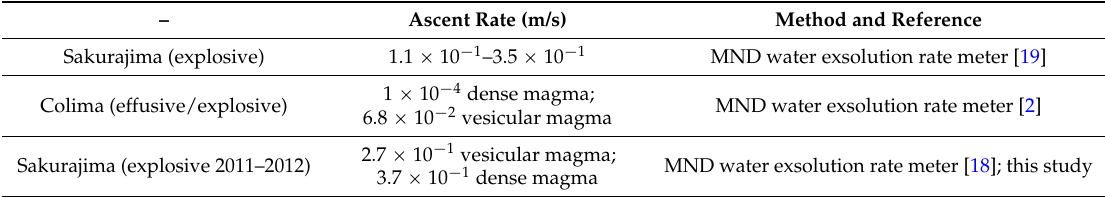
Table 3. A comparison of magma ascent rates for volcanoes which display similar Vulcanian activity.